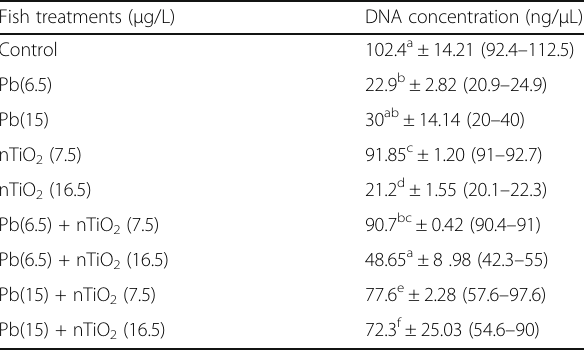
Superscripts of the same letter on the same row are not significant ( P